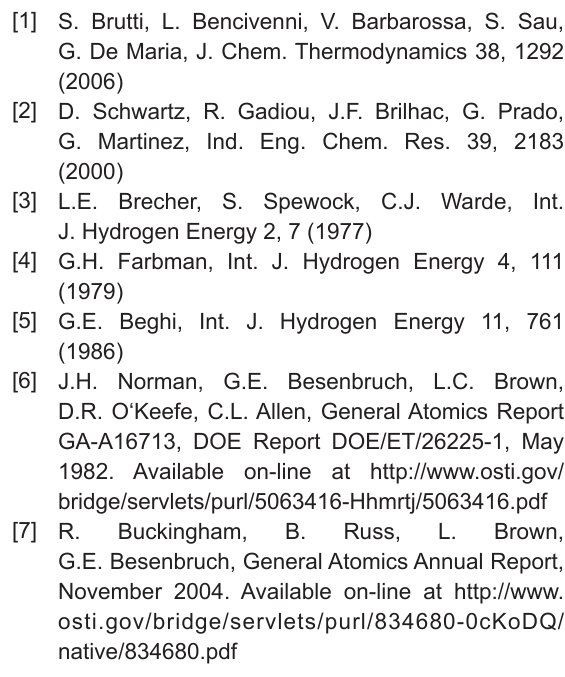
O catalyst: a - fresh sample; b - spent 2 3